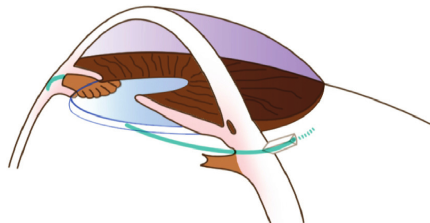
Figure 5: Diagram of position of haptics.